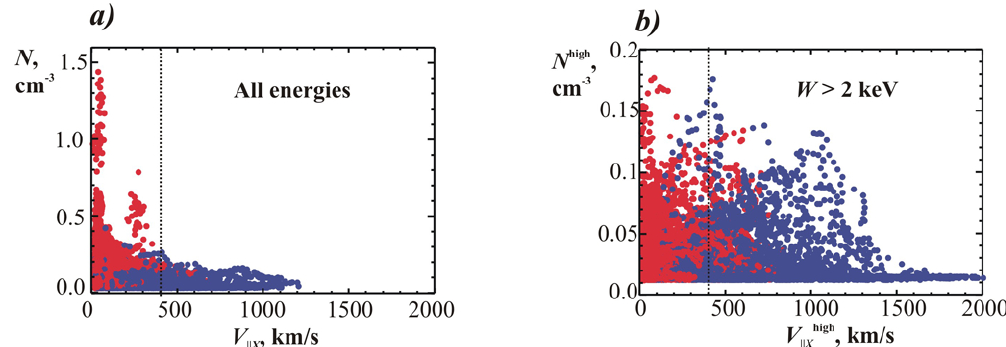
Fig. 9. (a) Scatterplot of the ion density N versus the X-component of the parallel velocity V || X , calculated for the entire energy range; (b) the same moments, but calculated for the high-energy part of the spectrum ( > 2keV). Data obtained in the PSBL are shown by blue dots and data measured in the outer PS region are displayed by red dots. Samples with very low densities ( < 0.01cm − 3 ) are not